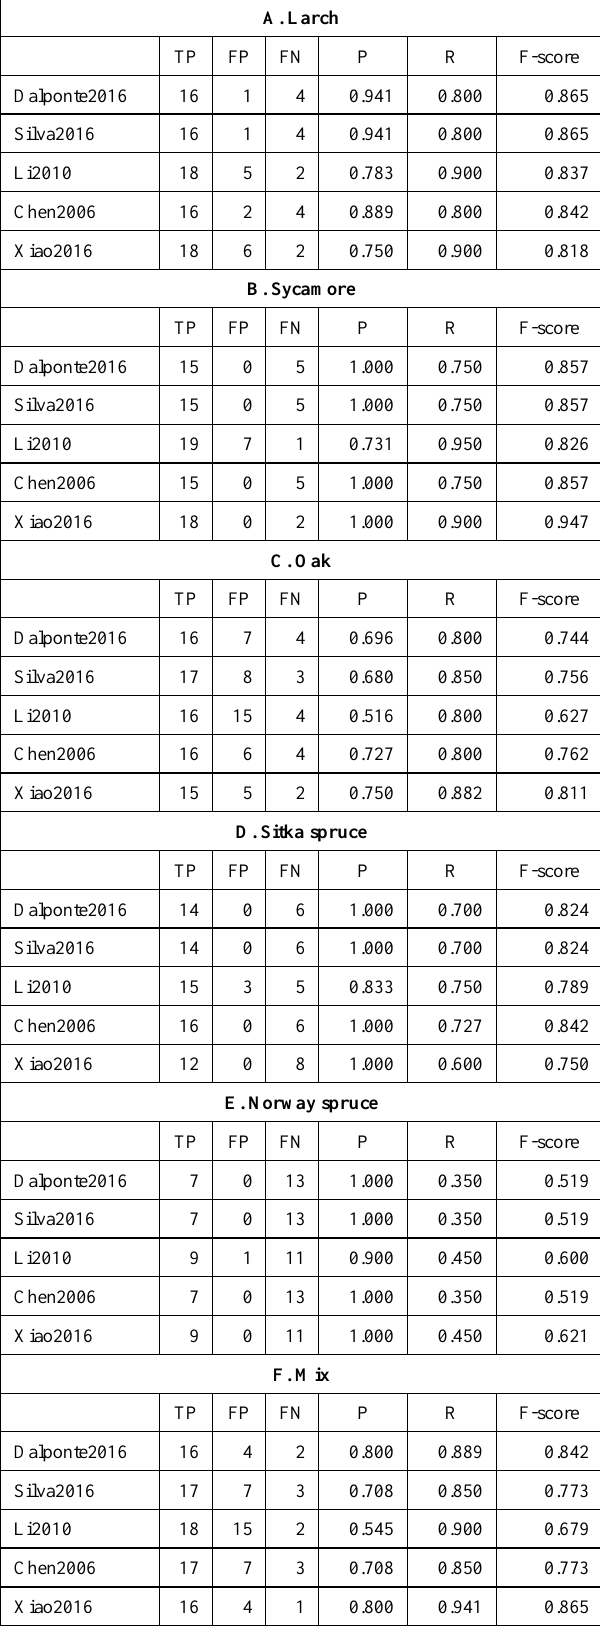
Table 2. Results of tree detection across all the plots with parameters set as constant (Test 2). TP indicates true positive – correctly detected, FP – false positive, oversegmentation, FN – false negative, undersegmentation, P – precision, R - recall.